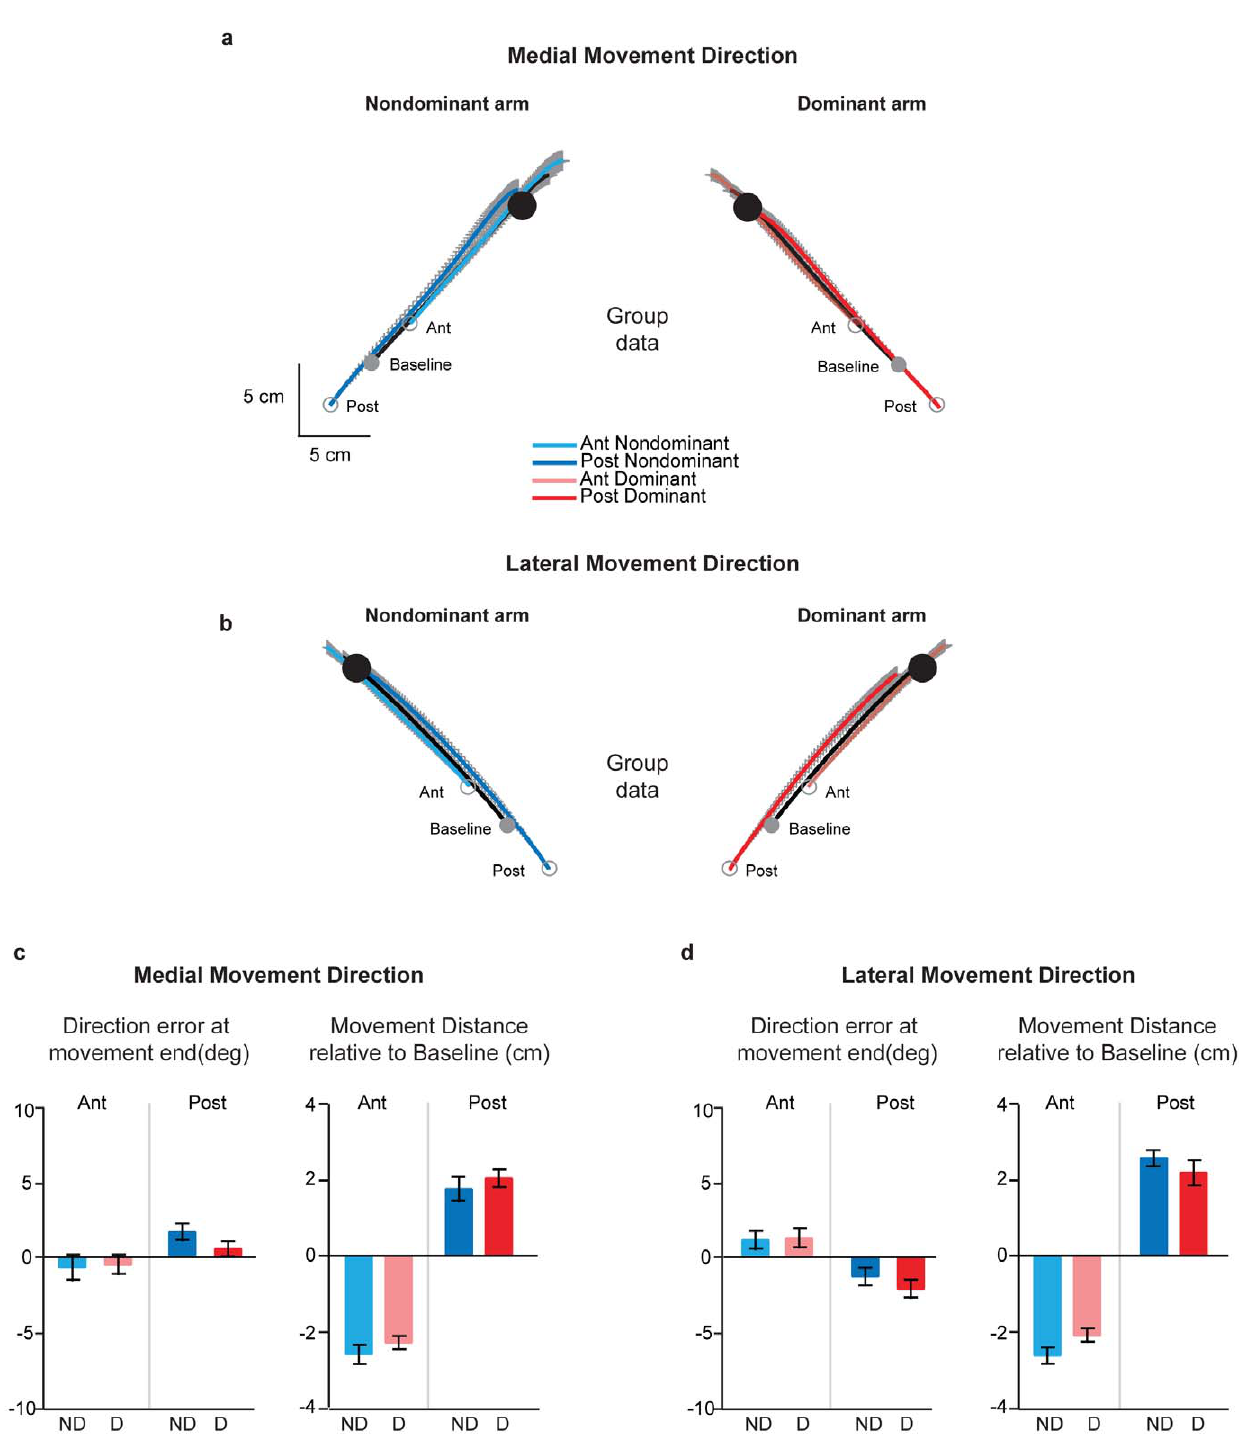
Figure 4. Effects of covertly shifting starting hand position collinearly on dominant (red) and non-dominant (blue) arm movements. (A) Mean hand trajectories in the medial direction across all subjects from the baseline and shifted start locations. Light and dark colors show movements from the anterior and posterior start positions respectively. Thick black lines represent mean baseline movements. Gray lines represent SE. Note that subjects saw only the baseline start and target positions. (B) Mean hand trajectories in the lateral direction across all subjects from the baseline and shifted start locations. Colors and line types represent the same information as in 4A . (C) Mean direction error at movement end (left panel) and normalized movement distance (right panel) for movements in the medial direction, separated by start location [anterior (light colors), posterior (dark colors)] and arm [dominant (red), non-dominant (blue)] Error bars represent SE. (D) Same information as 4C , except for movements in the lateral direction.